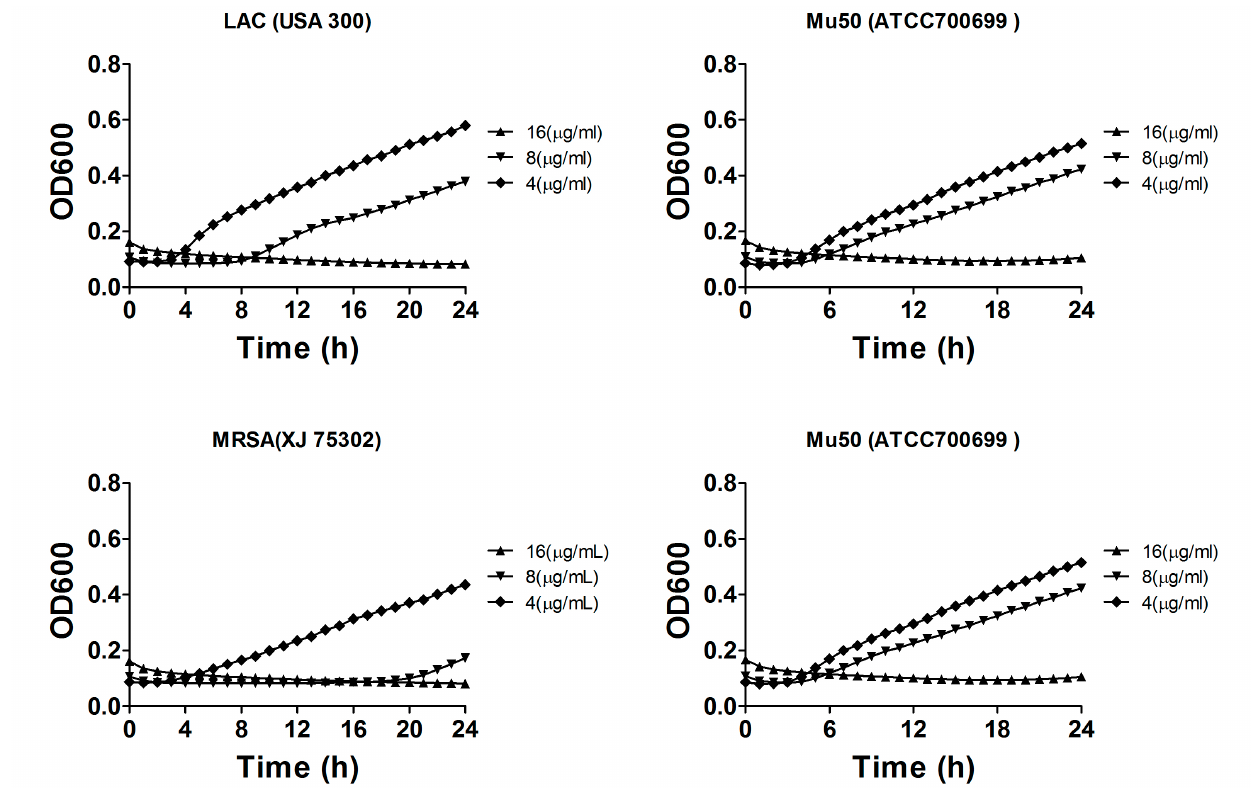
Figure 4. Concentration-dependent inhibition of compound 1 on the growth of S.